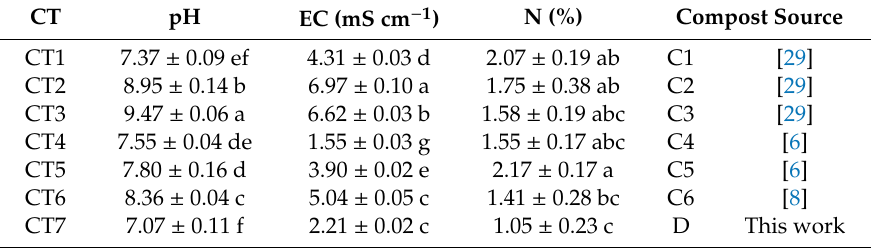
Table 1. Main physicochemical characteristics, pH, electric conductivity (EC), nitrogen content (N), and compost sources (C1-6, D) of the compost teas (CT1-7) used in this study. Di ff erent letters